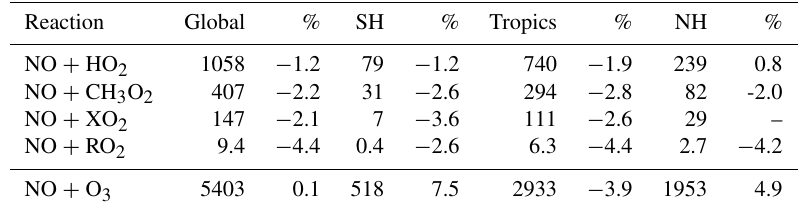
Table 5. The annual NO to NO 2 recycling terms involving peroxy radicals given in TgNyr − 1 for 2006 at 1 ◦ × 1 ◦ resolution. In mCB05v2 XO 2 represents lumped alkyl-peroxy radicals (Yarwood et al., 2005). The NO + RO 2 term is an aggregate of numerous specific peroxy- radical conversion terms in the modified CB05 mechanism (Williams et al., 2013; Tables 1 and 2). Also provided are the approximate percentage differences when comparing with 3 ◦ × 2 ◦ (equal to (1 ◦ × 1 ◦ ) – (3 ◦ × 2 ◦ ) / 3 ◦ × 2 ◦ ). The chemical tropopause is defined using the methodology outlined in Stevenson et al. (2006).